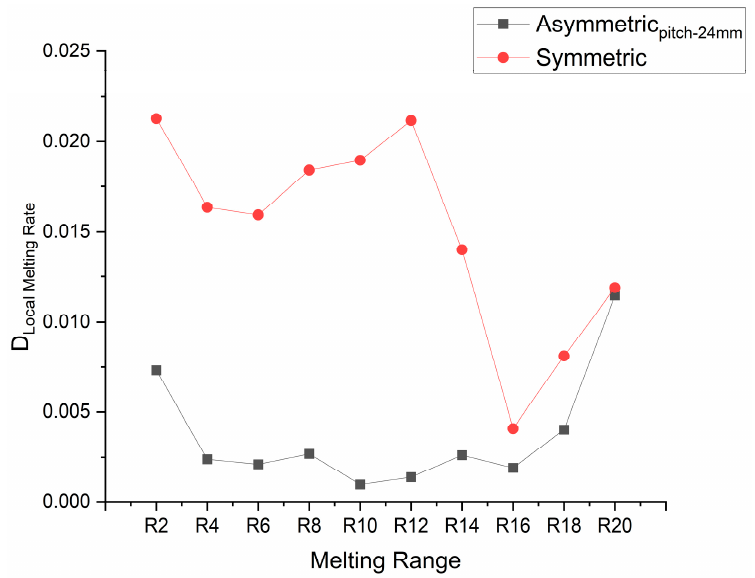
Figure 15. Deviation/difference of local averaged melting rate from the overall mean melting rate.